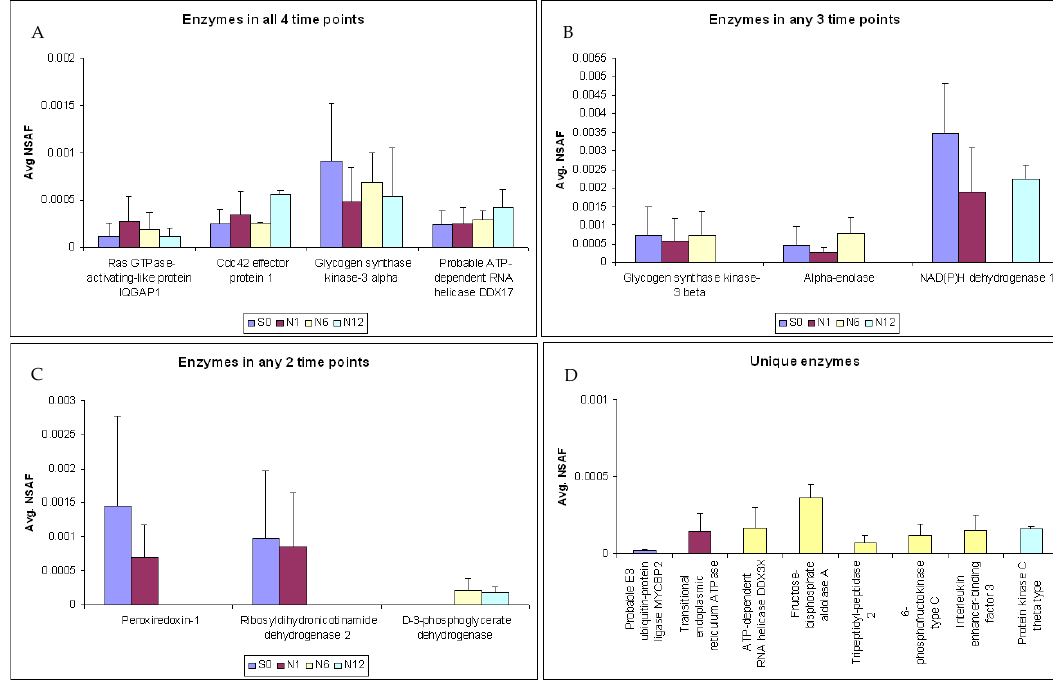
Figure 5. Bis-target enzymes involved in neurogenic differentiation. ( A ) Enzymes present in 4 time points, ( B ) enzymes in any 3 time points, C ) enzymes present in any 2 time points D ) unique enzymes.